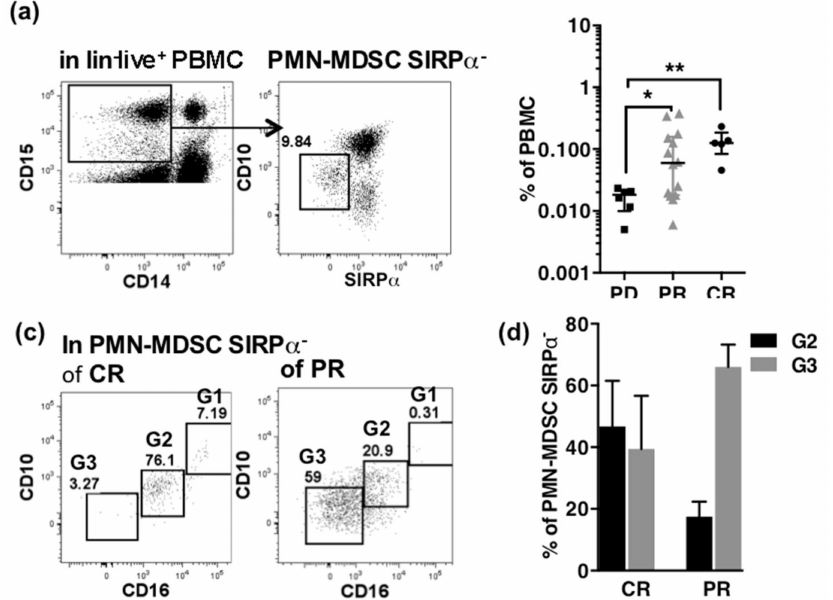
Figure 7. PMN-MDSC SIRP α − as a biomarker of response to ICI. ( a ) Gating of PMN-MDSC SIRP α − in lin - CD15 + CD14 − PBMCs. ( b ) Frequencies of PMN-MDSC SIRP α − according to the best radiologi- cal response to ICI (PD n = 6, CR n = 4, PR n = 9). p -values of Mann-Whitney U -tests are indicated on top of pairs: p < 0.05 *; p < 0.01 **. ( c ) Typical dot plots of co-expression of CD10 and CD16 in PMN-MDSC SIRP α − of a patient with CR (left) and a patient with PR (right). Gates for G1, G2 and G3 are indicated. ( d ) Distribution of PMN-MDSC SIRP α − within G2 and G3 subsets according to best response to ICI (CR n = 5, PR n =